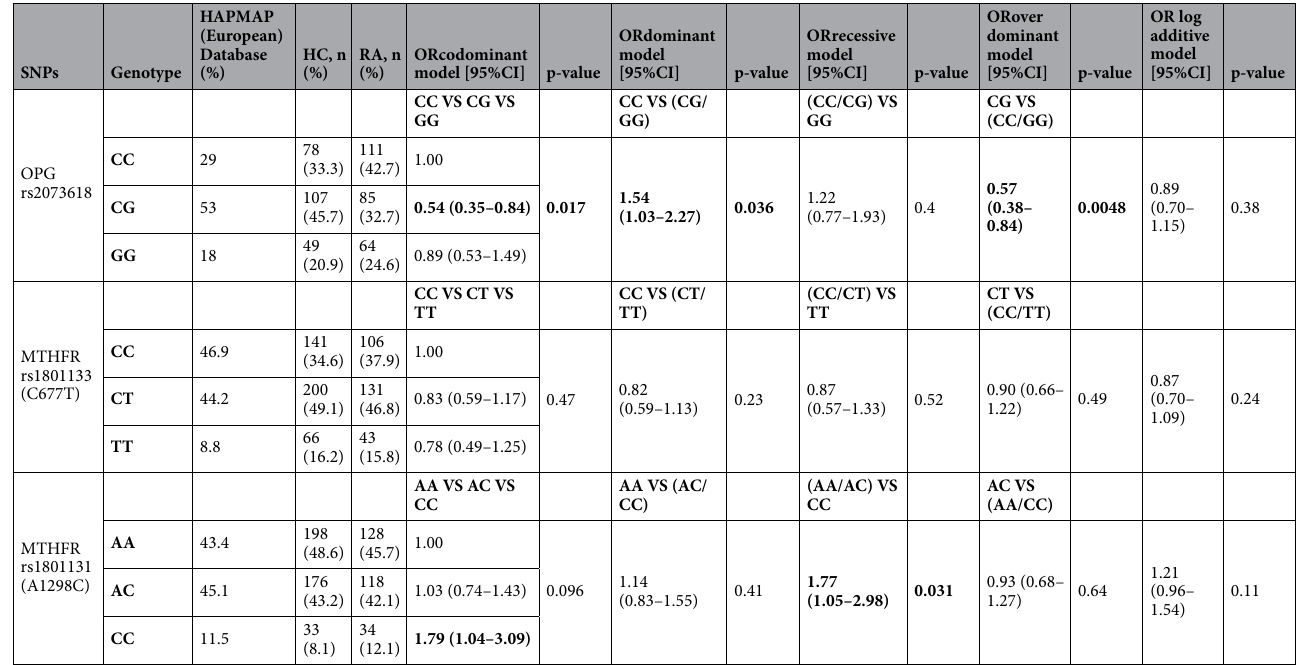
Table 1. Prevalence of the OPG rs2073618 and the MTHFR rs1801133 and rs1801131 SNP genotypes in RA patients and HC, adjusted by gender and age. Genotypes, OR and p-value for the five genetic models (codominant, dominant, recessive, overdominant and additive) were estimated with SNPstats software (statistically significant if p < 0.05). OPG osteoprotegerin, MTHFR methylene tetrahydrofolate reductase, OR odds ratio, SNP single nucleotide polymorphism, VS versus, RA rheumatoid arthritis, HC healthy controls, HAPMAP haplotype map. Significant values are in